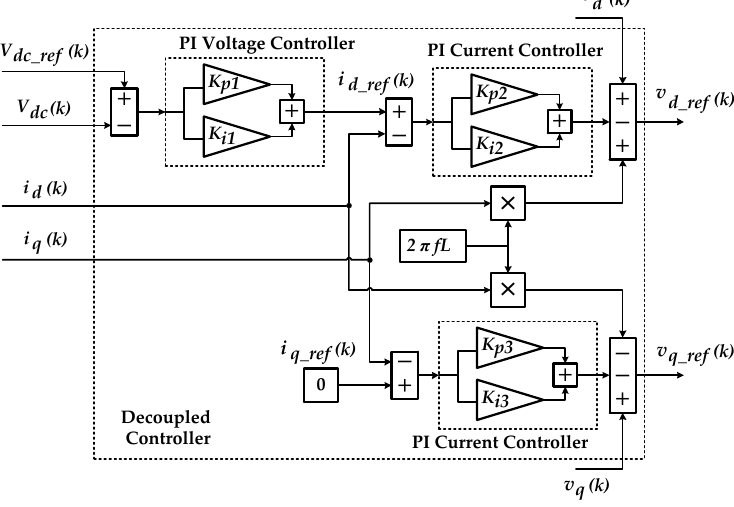
Figure 5. The control structure of the decoupled controller for the VOC technique.